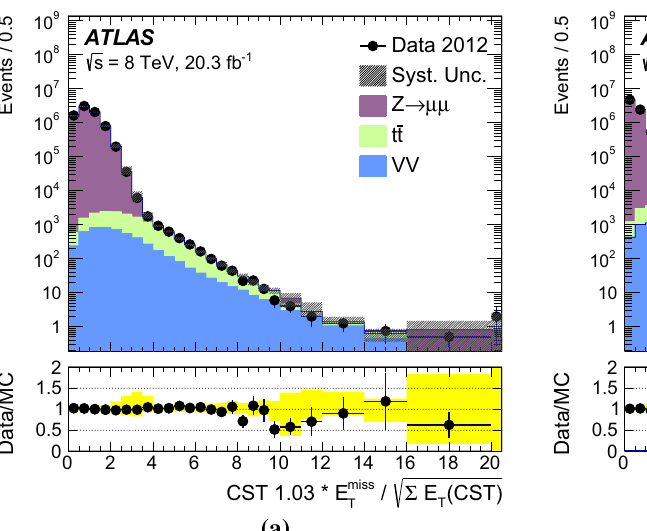
Fig. 14 The proxy for E miss significance is shown in data and MC T simulation events satisfying the Z → μμ selection for the a CST and b TST E miss algorithms. The solid band shows the combined MC sta- T